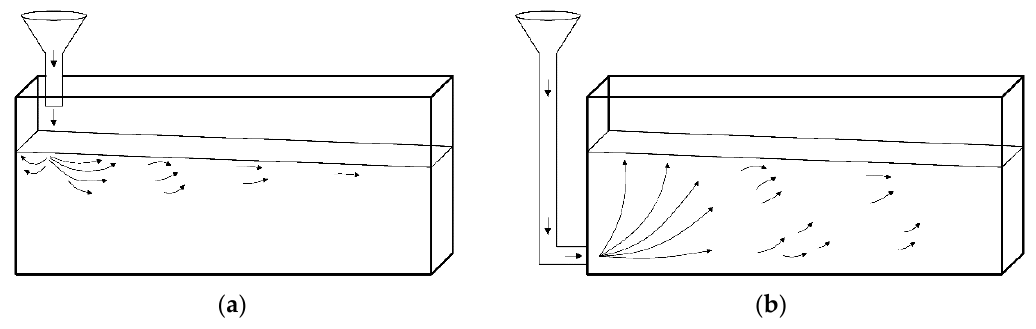
Figure 1. Typical methods of placing self-compacting concrete (SCC): ( a ) pumping from the above, ( b ) pumping from the bottom.